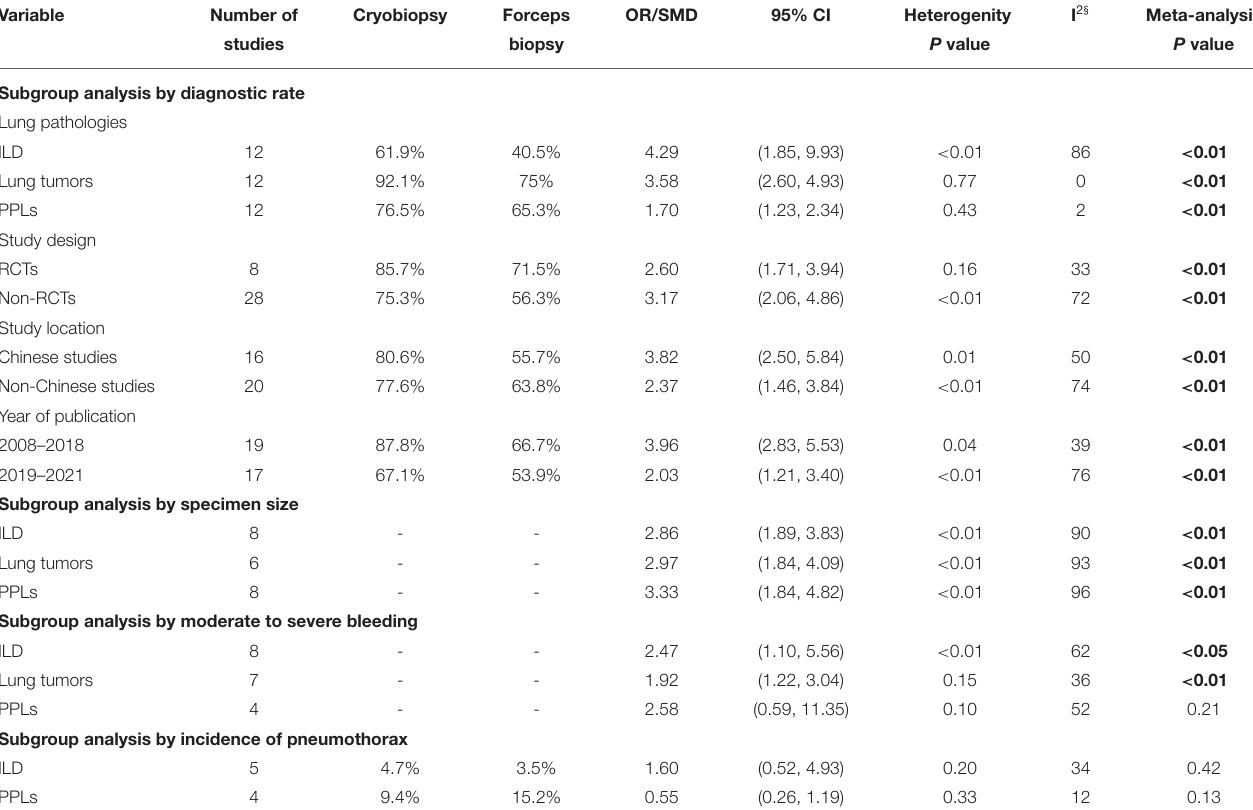
TABLE 2 | Summarized meta-analysis results of subgroup